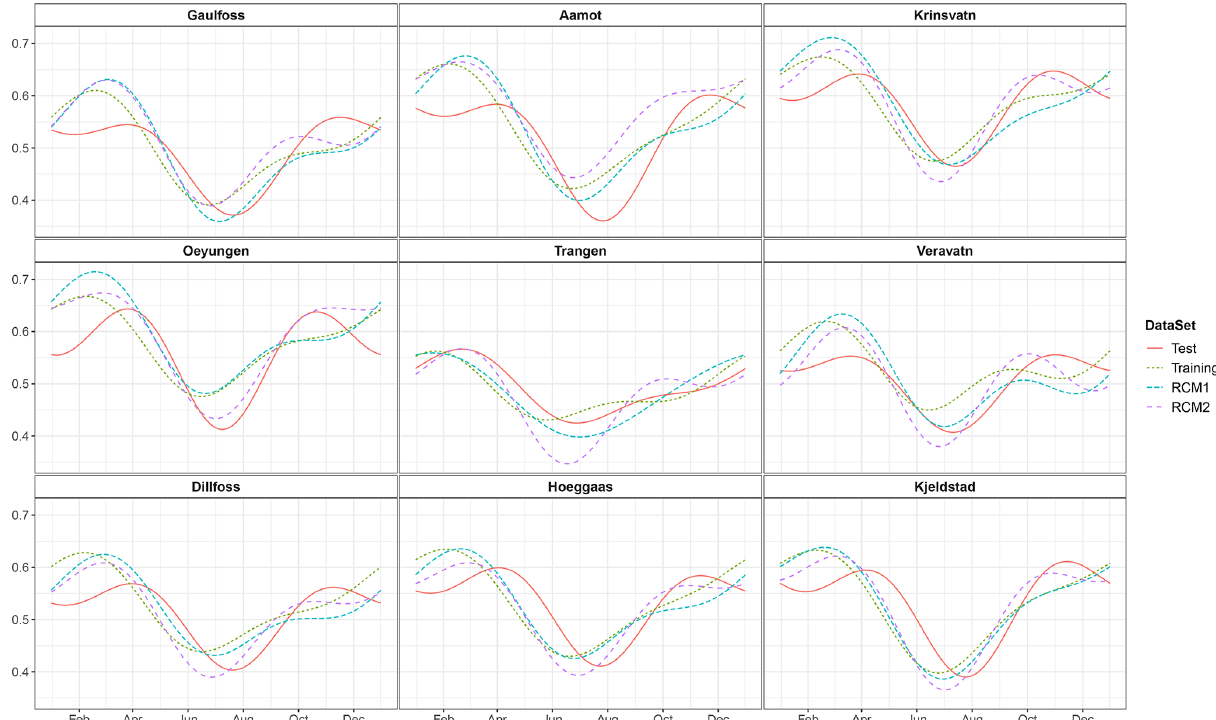
Figure 9. Smoothly changing daily estimates of the correlation coefficient ρ t in Eq. (11) for each catchment, estimated based on the seNorge data in the training period 1957–1986 (green dotted lines), inferred by adding the climate change information from RCM1 (cyan dashed lines) and RCM2 (purple dashed lines) for the test period 1987–2005, and as a reference the values estimated based on the seNorge data in the test period 1987–2005 (red solid lines).